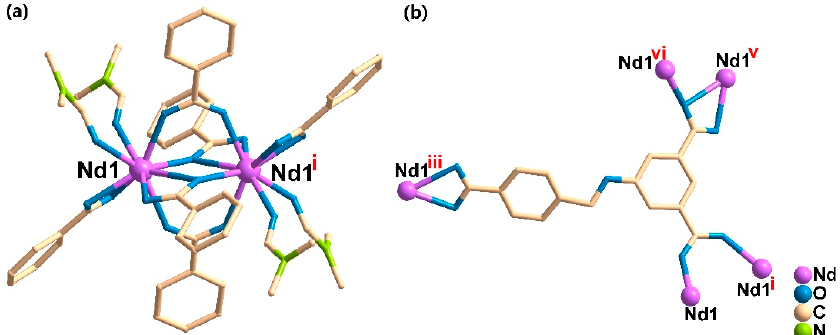
Figure 1. The coordination environment of ( a ) inorganic building units {Nd 2 (COOR) 6 (DMF) 4 } and ( b ) organic ligand L 3– .